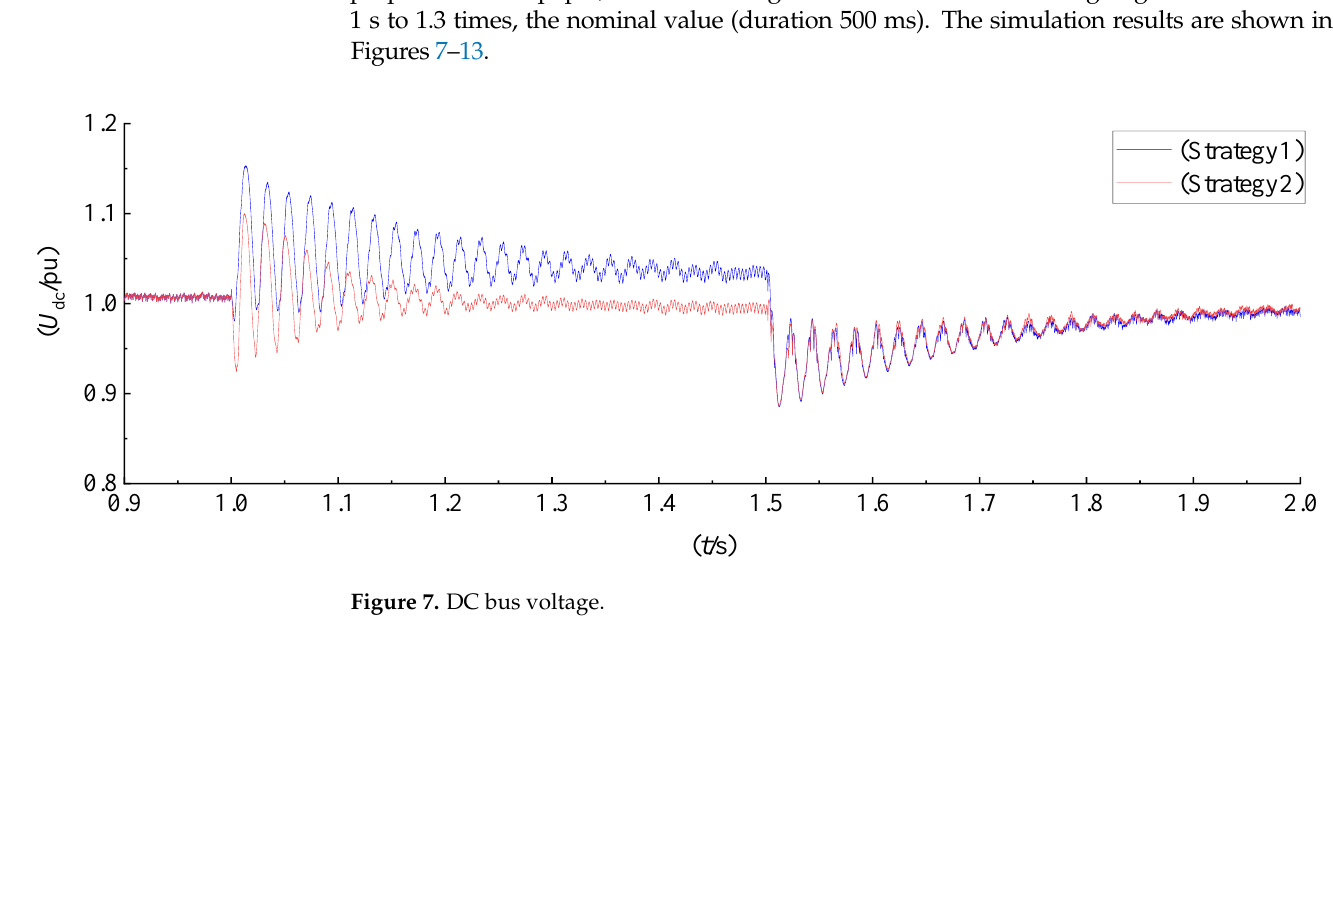
Table 4. Results for optimal k values and DC bus voltages for different voltage rises.